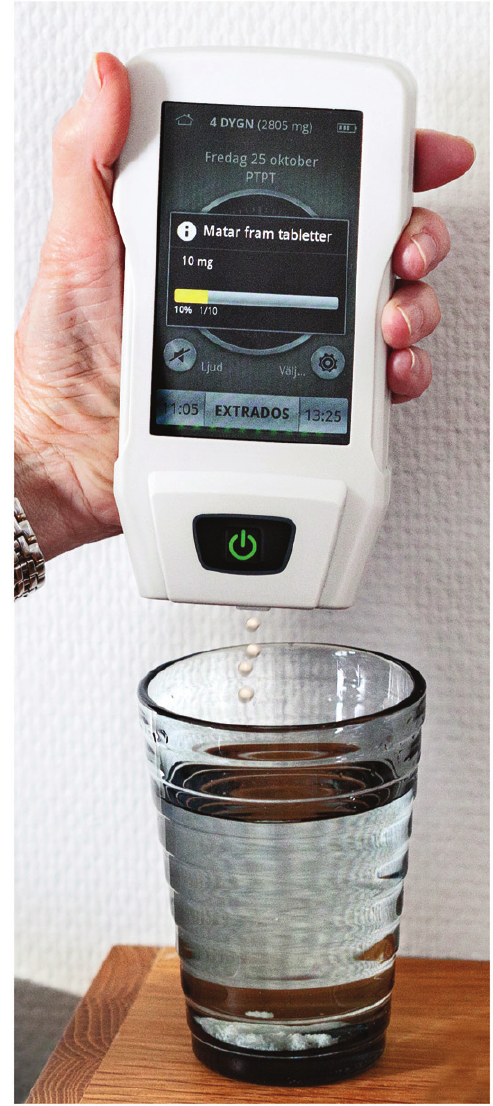
Figure 3. Automatic dose dispenser for levodopa/carbidopa